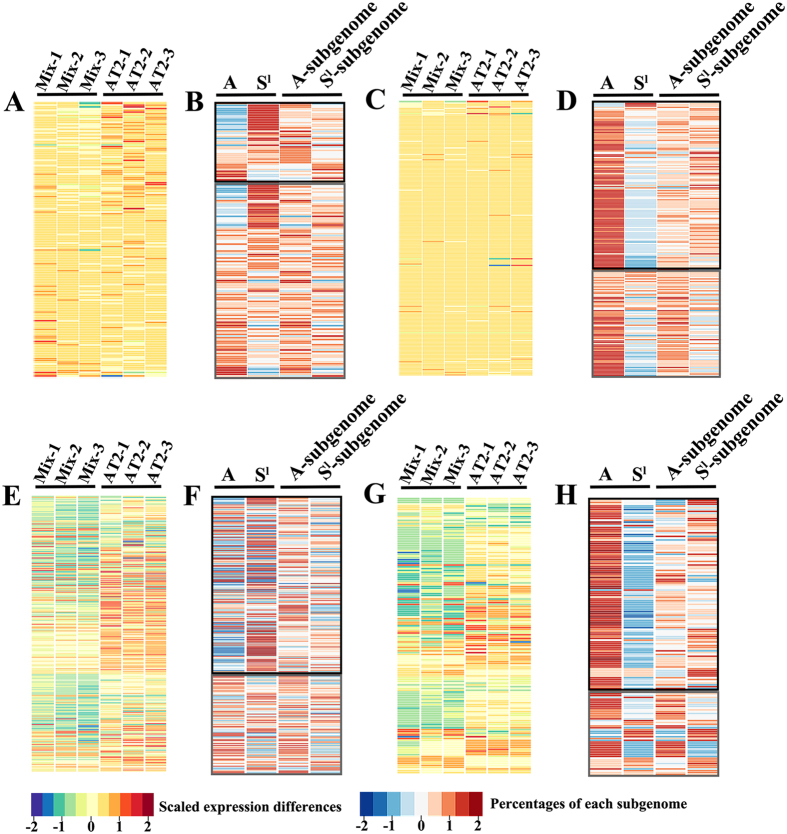
Clustering of microarray data-based nonadditive and additive expressing genes in AT2 relative to its MPVs (see in Method and Materials) as total expression (all three biological replicates are shown) in relation to the cDNA pyrosequencing-based relative transcript contribution by the A and Sl subgenomes for each studied gene in leaf and young-inflorescence, respectively.The upper panels are the results of additive expression genes in leaf (A,B) and young-inflorescence (C,D), respectively, while the lower panels are the results of nonadditive expression genes in leaf (E,F) and young-inflorescence (G,H), respectively. Altered partitioning by the A vs. Sl subgenome transcripts in AT2relative to the original parental ortholog transcript proportion in the in vitro “hybrids” were determined by statistical analysis: t test, P < 0.05 for altered partitioning (framed by black rectangles), and P > 0.05 for unaltered partitioning (framed by grey rectangles). In total, 94 and 95 additive expression genes were analyzed for in leaf and young-inflorescence, respectively, while 125 and 67 nonadditive expression genes were analyzed for leaf and young-inflorescence, respectively. The color key is indicated.